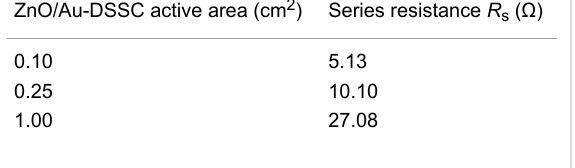
Table 5: Series resistance ( R s ) of the ZnO/Au-nanocomposite DSSC measured for different active areas of the solar cells using a one-diode equivalent-circuit model for the DSSC.